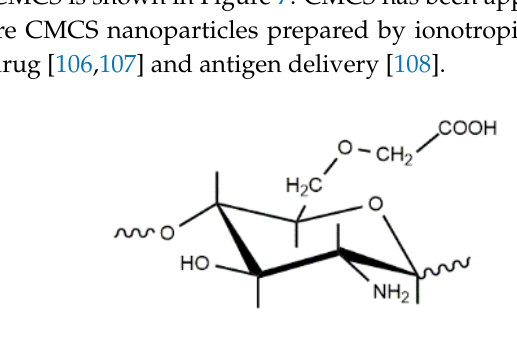
Figure 7. The structural unit of carboxymethyl chitosan.